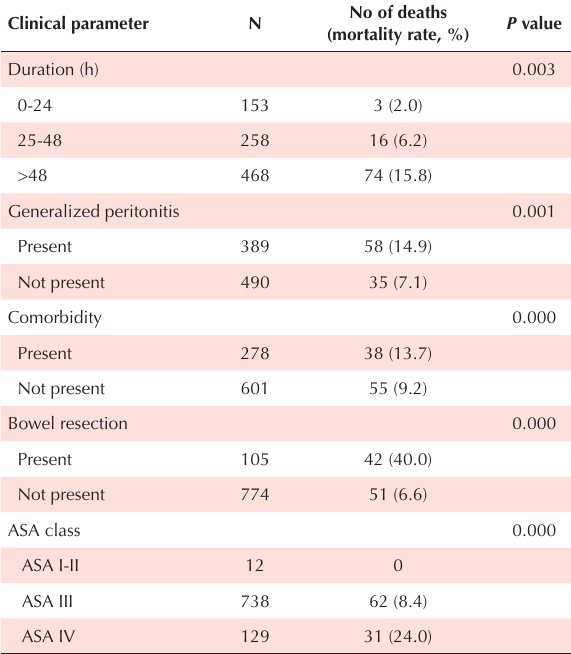
Table 5. Clinical predictors of mortality Clinical